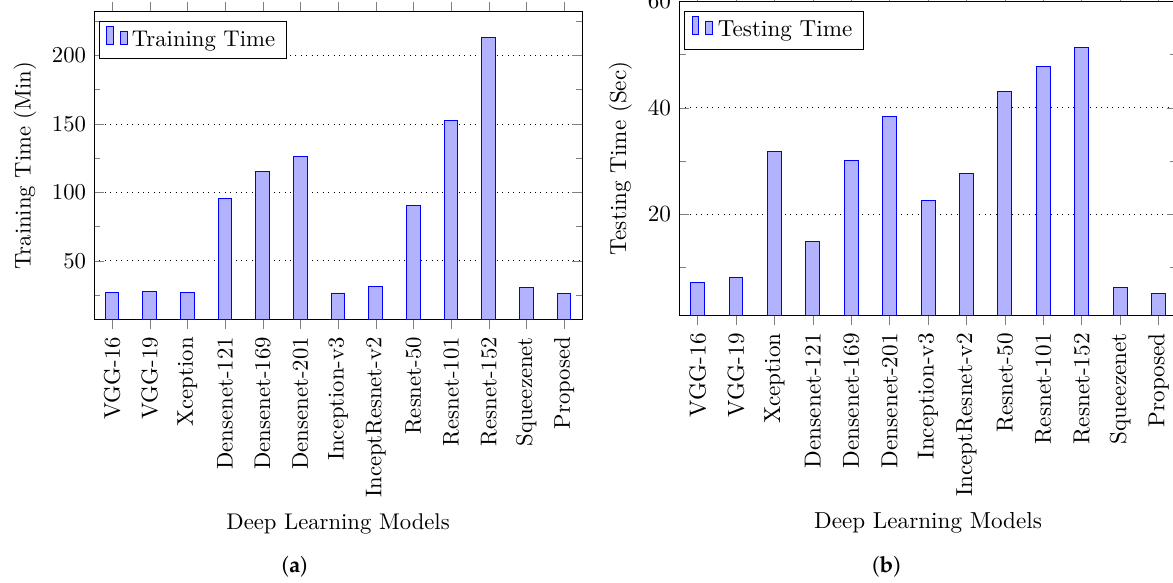
Figure 7. Execution time analysis: ( a ) Training time comparison of deep learning models for malaria detection., ( b ) Testing time comparison of deep learning models for malaria detection. The reported time is the time the model takes for the whole test dataset (8272